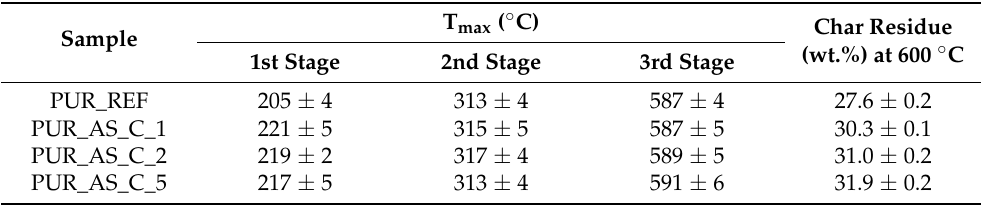
Table 5. The results of thermal stability of PUR composites.